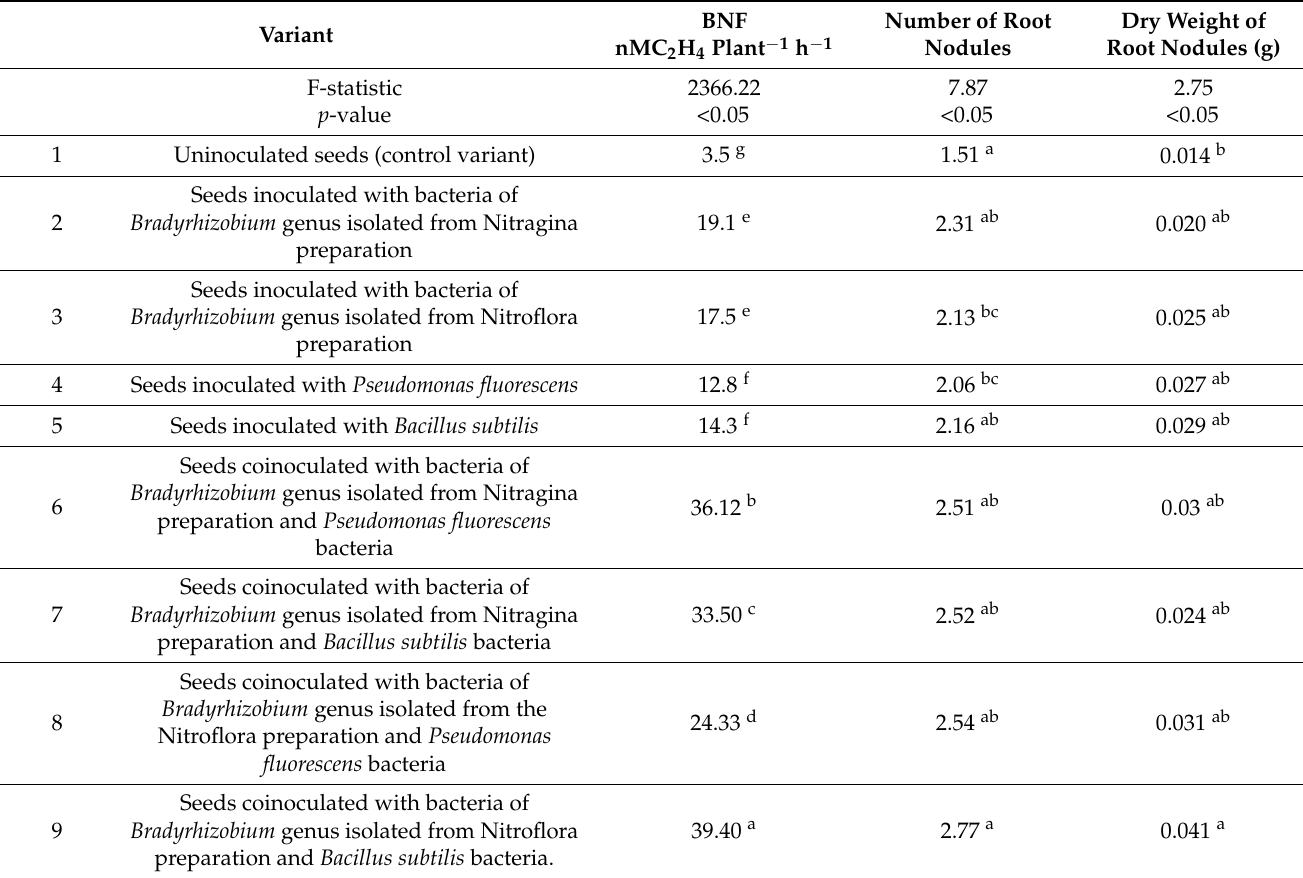
Table 3. The influence of different variants of inoculation of white lupine seeds on selected diazotro- phy parameters. ANOVA and Tukey’s post hoc test for inoculation